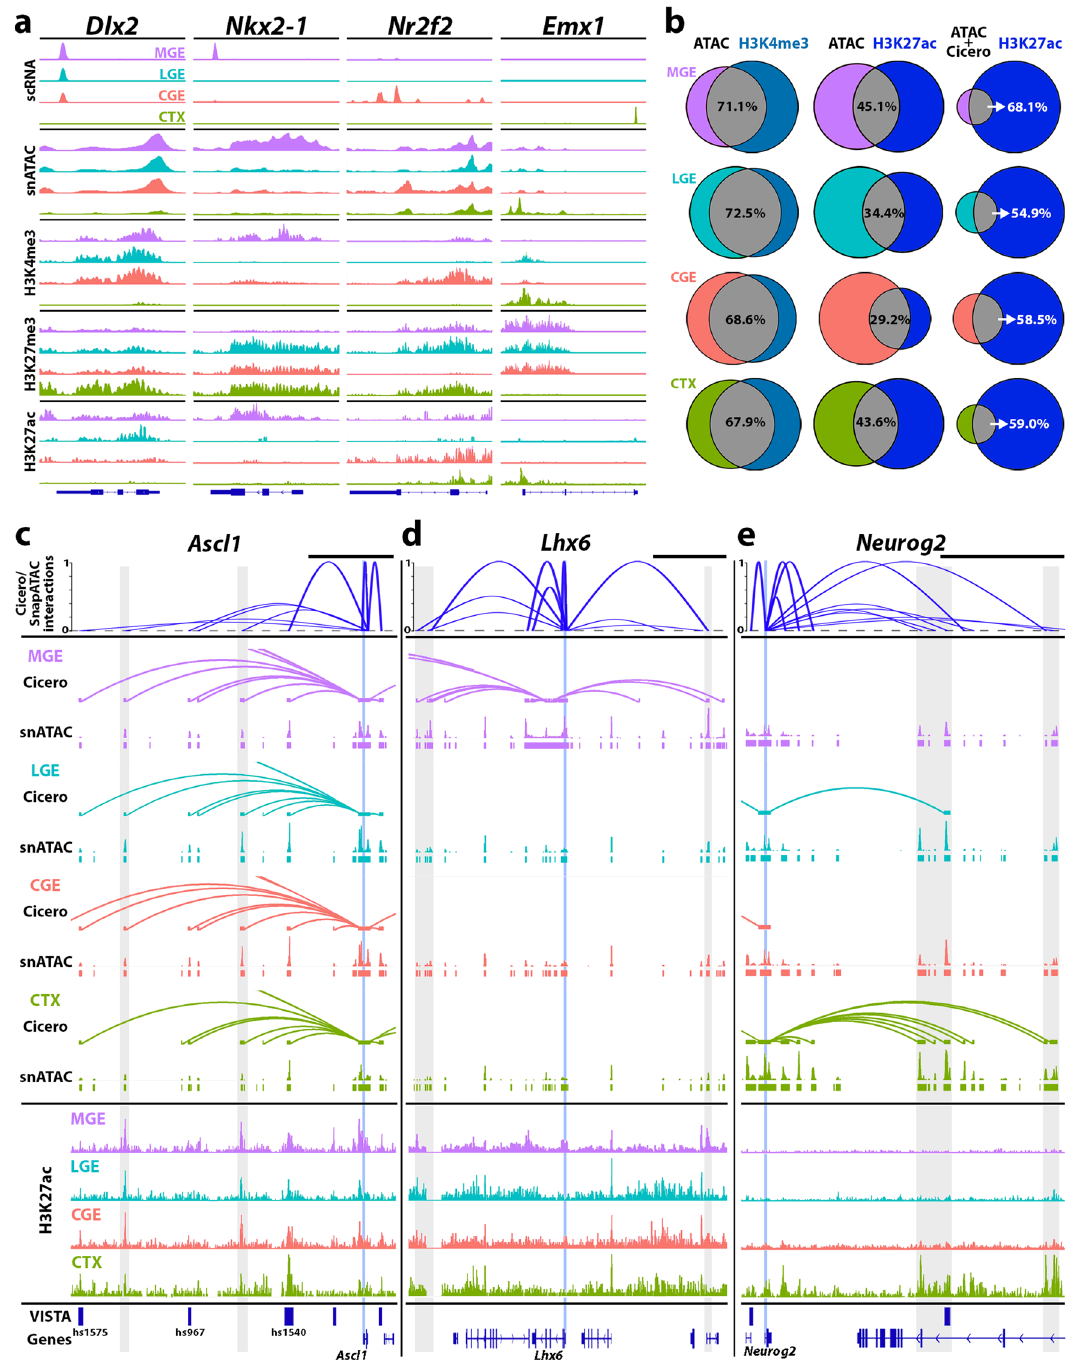
Fig. 6 Histone modi fi cations within mouse embryonic neural progenitors. a Tracks of scRNA-Seq, snATAC-Seq, and histone modi fi cations correlated with active promoters (H3K4me3), repressed genes (H3K27me3), and active enhancers (H3K27ac) in MGE, LGE, CGE, and cortex (CTX); pan-GE Dlx2 , MGE-restricted Nkx2-1 , CGE-enriched Nr2f2 , and cortex-restricted Emx1 . b Venn diagrams comparing ATAC peaks at promoter regions vs. H3K4me3 peaks at promoters (left); ATAC peaks outside promoters vs. H3K27ac peaks outside promoters (middle); and ATAC peaks with Cicero connections to a gene promoter vs. H3K27ac peaks outside promoters. Percentages represent % of ATAC peaks overlapping with histone marks per brain region. Circle size represents the relative number of peaks in each group. c – e Top, Integration of gene-enhancer predictions using Cicero/SnapATAC interactions as in Supplementary Fig. 6. Arc height of Cicero/SnapATAC interactions track indicates relative interaction scores between gene TSS and predicted cis- regulatory elements. Middle, tissue-speci fi c Cicero connections with snATAC peaks. Cicero connections were fi ltered to retain scores >0.25, and connections where one anchor intersects a gene TSS while the second anchor does not intersect promoter regions of any genes. Bottom, H3K27ac tracks with VISTA hits for Ascl1 ( c ), Lhx6 ( d ), and Neurog2 ( e ). Vertical light blue line denotes TSS for each gene, gray-shaded rectangles indicate loci of interest related to TSS. VISTA hits near genes are depicted with dark blue bars. Black scale bars above Cicero/SnapATAC tracks = 50 kb.